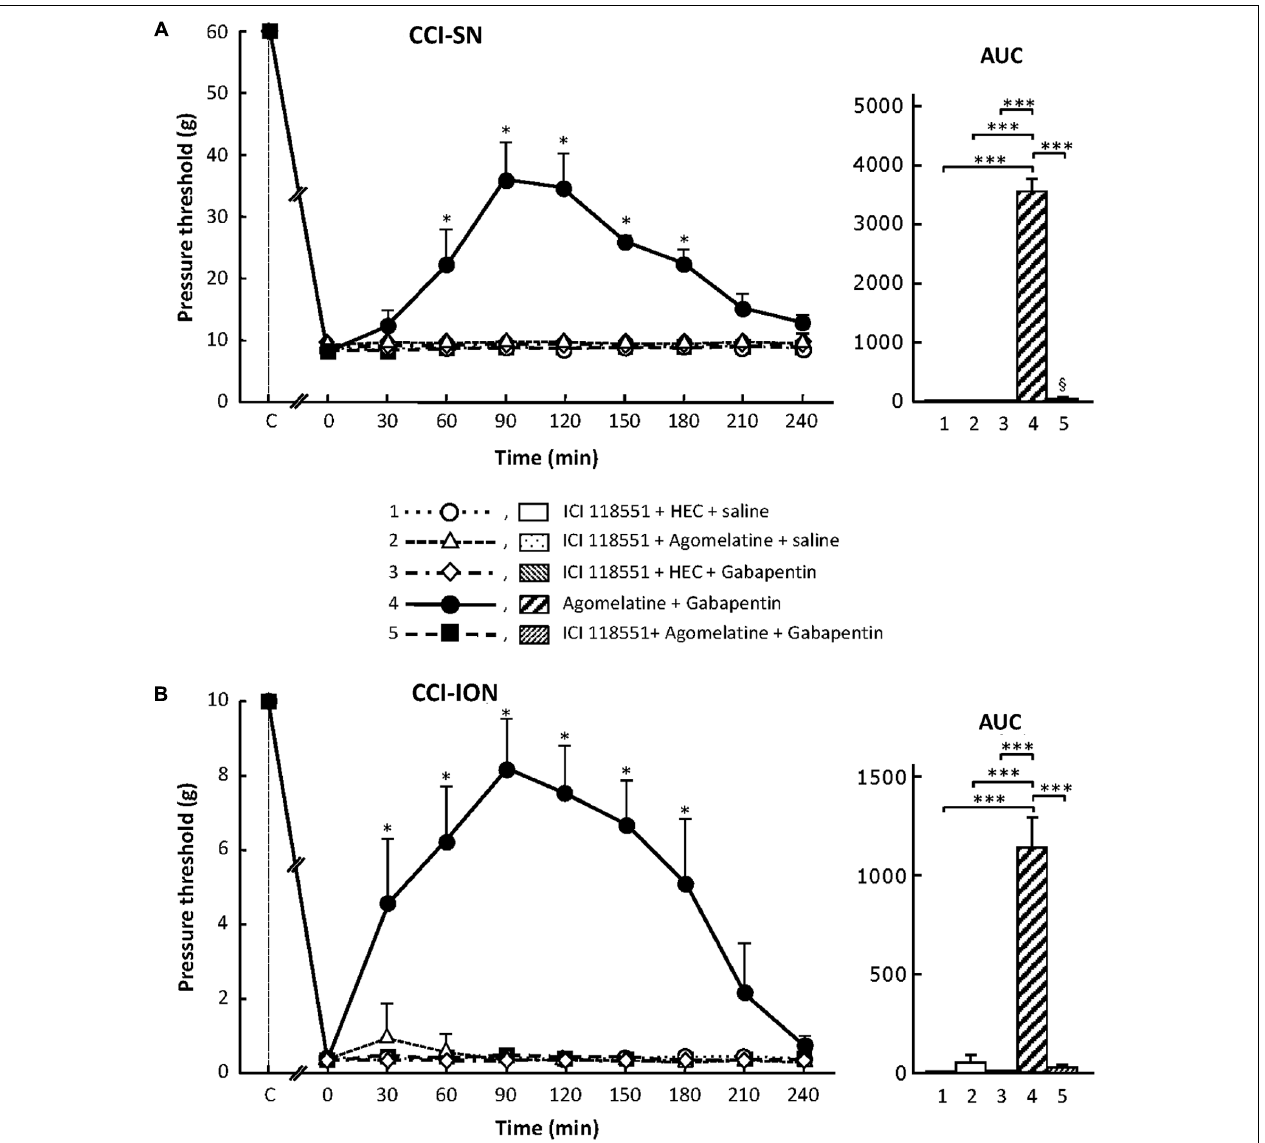
FIGURE 8 | Effects of ICI 118551 alone or co-administered with agomelatine, gabapentin or ‘agomelatine + gabapentin’ on mechanical allodynia in CCI-SN (A) or CCI-ION (B) rats. Left panels: ICI 118551 (5 mg/kg i.p.) or its vehicle (saline) was administered 30 min before other treatments in rats whose right SN (A) or ION (B) had been ligated 2 weeks before. Five different treatment groups were made: (1) ICI 118551 + HEC + saline, (2) ICI 118551 + agomelatine (45 mg/kg) + saline, (3) ICI 118551 + HEC + gabapentin (50 mg/kg), (4) agomelatine + gabapentin, (5) ICI 118551 + agomelatine + gabapentin. Pressure threshold values (as g) were determined as described in the legend to Figure 1 . Each point is the mean ± SEM of independent determinations in n rats for each condition. ∗ P < 0.05, compared with pressure threshold values determined just prior to drug injection, one way ANOVA with repeated measures, Dunnett’s test. C on abscissa: intact healthy rats before surgery. In both CCI-SN (A) and CCI-ION (B) rats, ‘saline+HEC’-treated groups were also included, but, for the sake of clarity, corresponding data are not represented as they superimposed with those obtained in rats treated with ICI 118551 + HEC + saline. Right panels: AUC values calculated from the